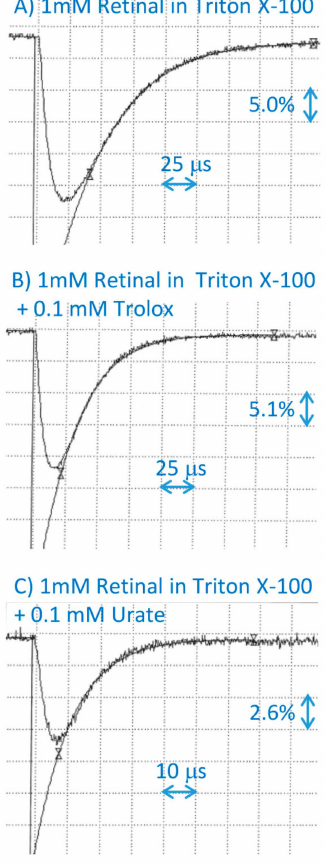
Figure 2. Representative kinetics of the formation and decay of retinal cation radicals monitored at 590 nm after the pulse radiolysis of aqueous solution saturated with N 2 O and containing 10 mM of phosphate, pH 7, 0.1 M KBr, 1 mM of retinal incorporated in 2% Triton X-100 micelles, in the absence ( A ) and presence of 0.1 mM of Trolox ( B ), or uric acid ( C ). 2.2. Interaction of Cation Radical of Retinoic Acid with Tocopherols, Trolox and